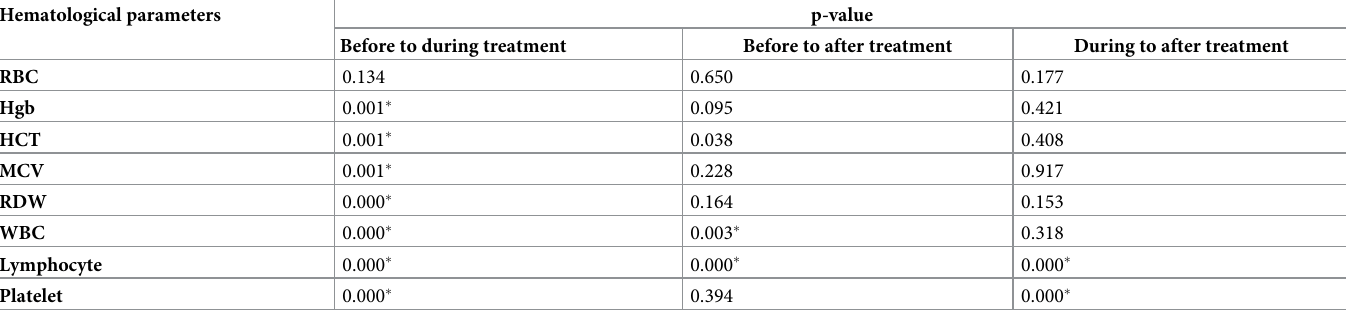
Table 3. Wilcoxon rank test for the comparison of hematological parameters before, during, and after treatment among breast cancer patients at UoG-CSH, North- west Ethiopia, 2020. Hematological parameters p-value Before to during treatment Before to after treatment During to after treatment